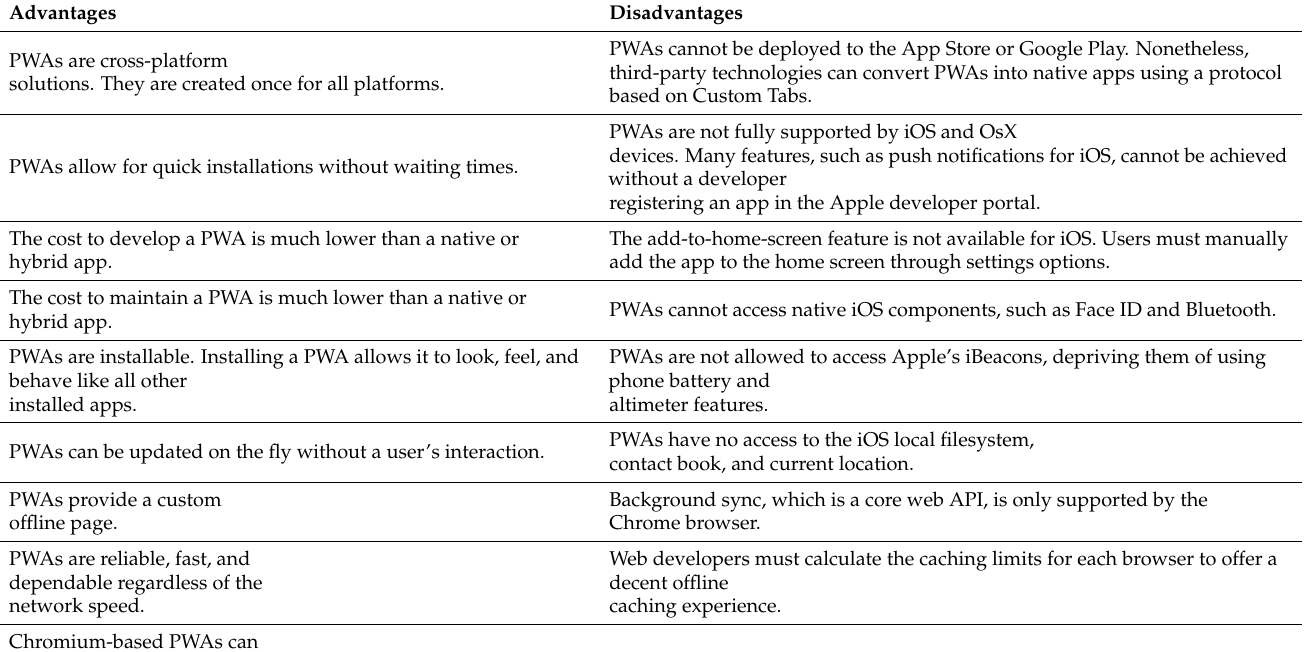
Table A1. Advantages and disadvantages of progressive web apps